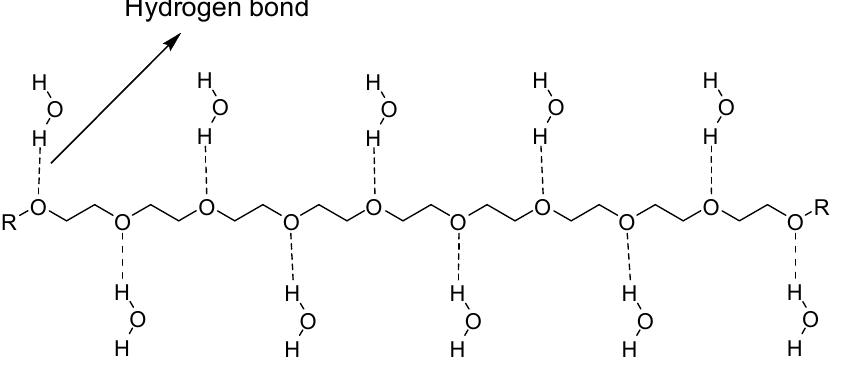
Figure 10. Schematic diagram of hydrogen bonding between ethoxy units and water molecules.